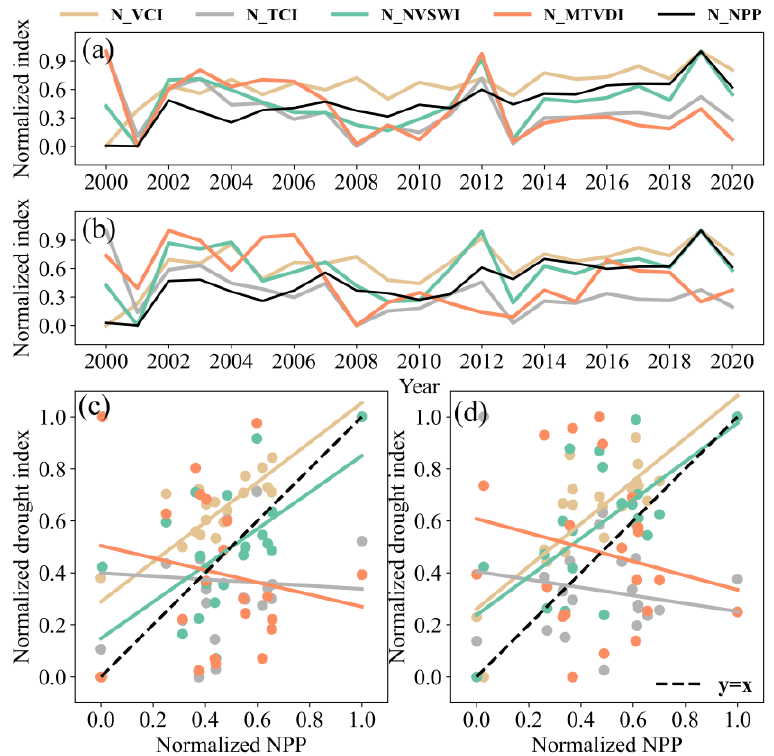
Figure 5. Temporal changes of vegetation status-based drought index and NPP during the growing season from 2000 to 2020: ( a ) grassland and forest area, ( b ) farmland area. The scatter plot distribution of vegetation status-based drought index and NPP over 2000 – 2020: ( c ) grassland and forest area and ( d ) farmland area.